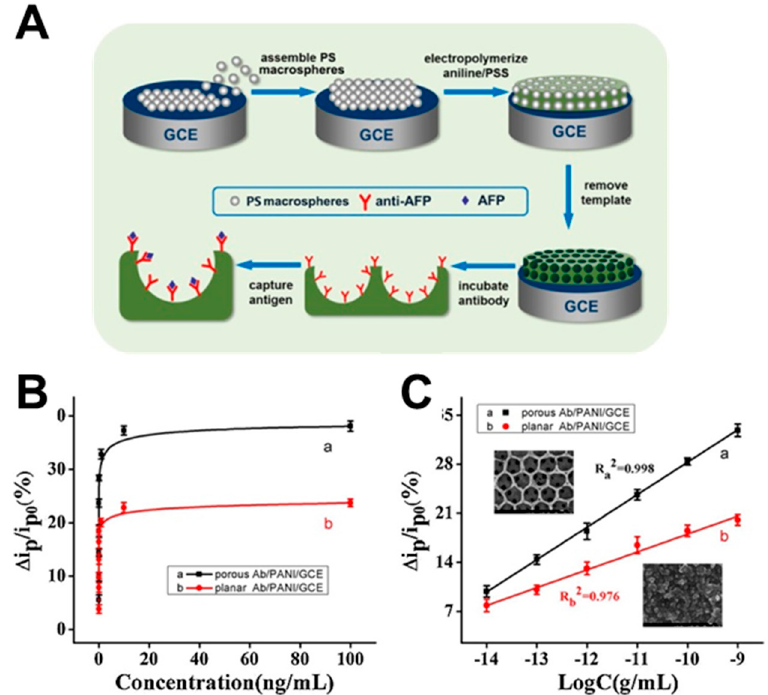
Figure 10. ( A ) Fabrication process of the alpha-1-fetoprotein (AFP) immunosensor based on macroporous polyaniline (PANI). ( B ) The dynamic response range of (a) porous PANI/ glassy carbon electrode (GCE) and (b) planar PANI/GCE upon a function of AFP concentrations. ( C ) The corresponding calibration curves of (a) porous PANI/GCE and (b) planar PANI/GCE. Error bars indicate the standard deviation of three measurements [273]. Reproduced from Liu et al. (2018) with permission (Copyright © 2017 Elsevier B.V. All rights